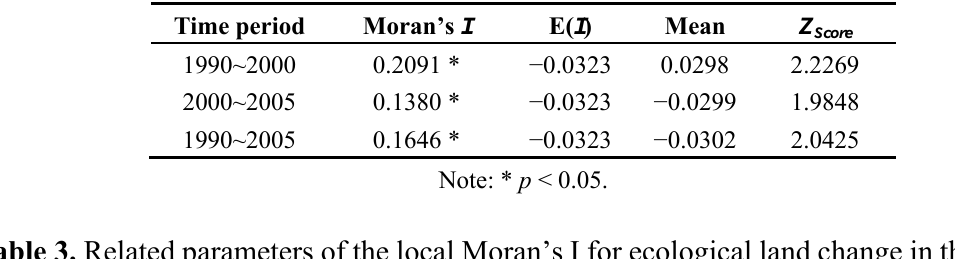
Table 2. Global Moran’s I value and its statistical test for ecological land change from 1990 to 2005.